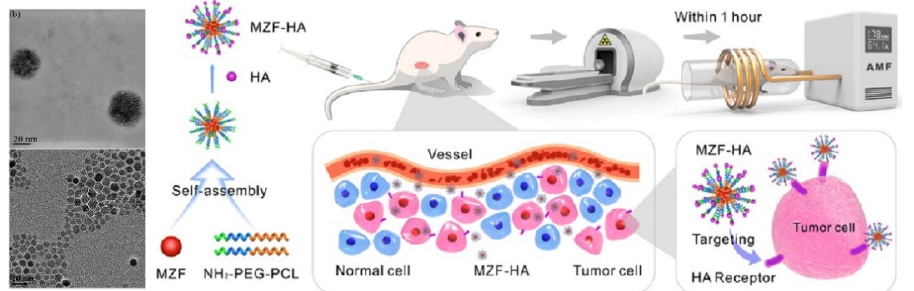
Figure 2. Scheme of the application of the Mn-Zn ferrite nanoclusters in an in vivo AFM experiment. On the left, TEM images of single nanoparticles (bottom) and clustered ones (top). Adapted with permission from [48], Copyright 2020, American Chemical Society.